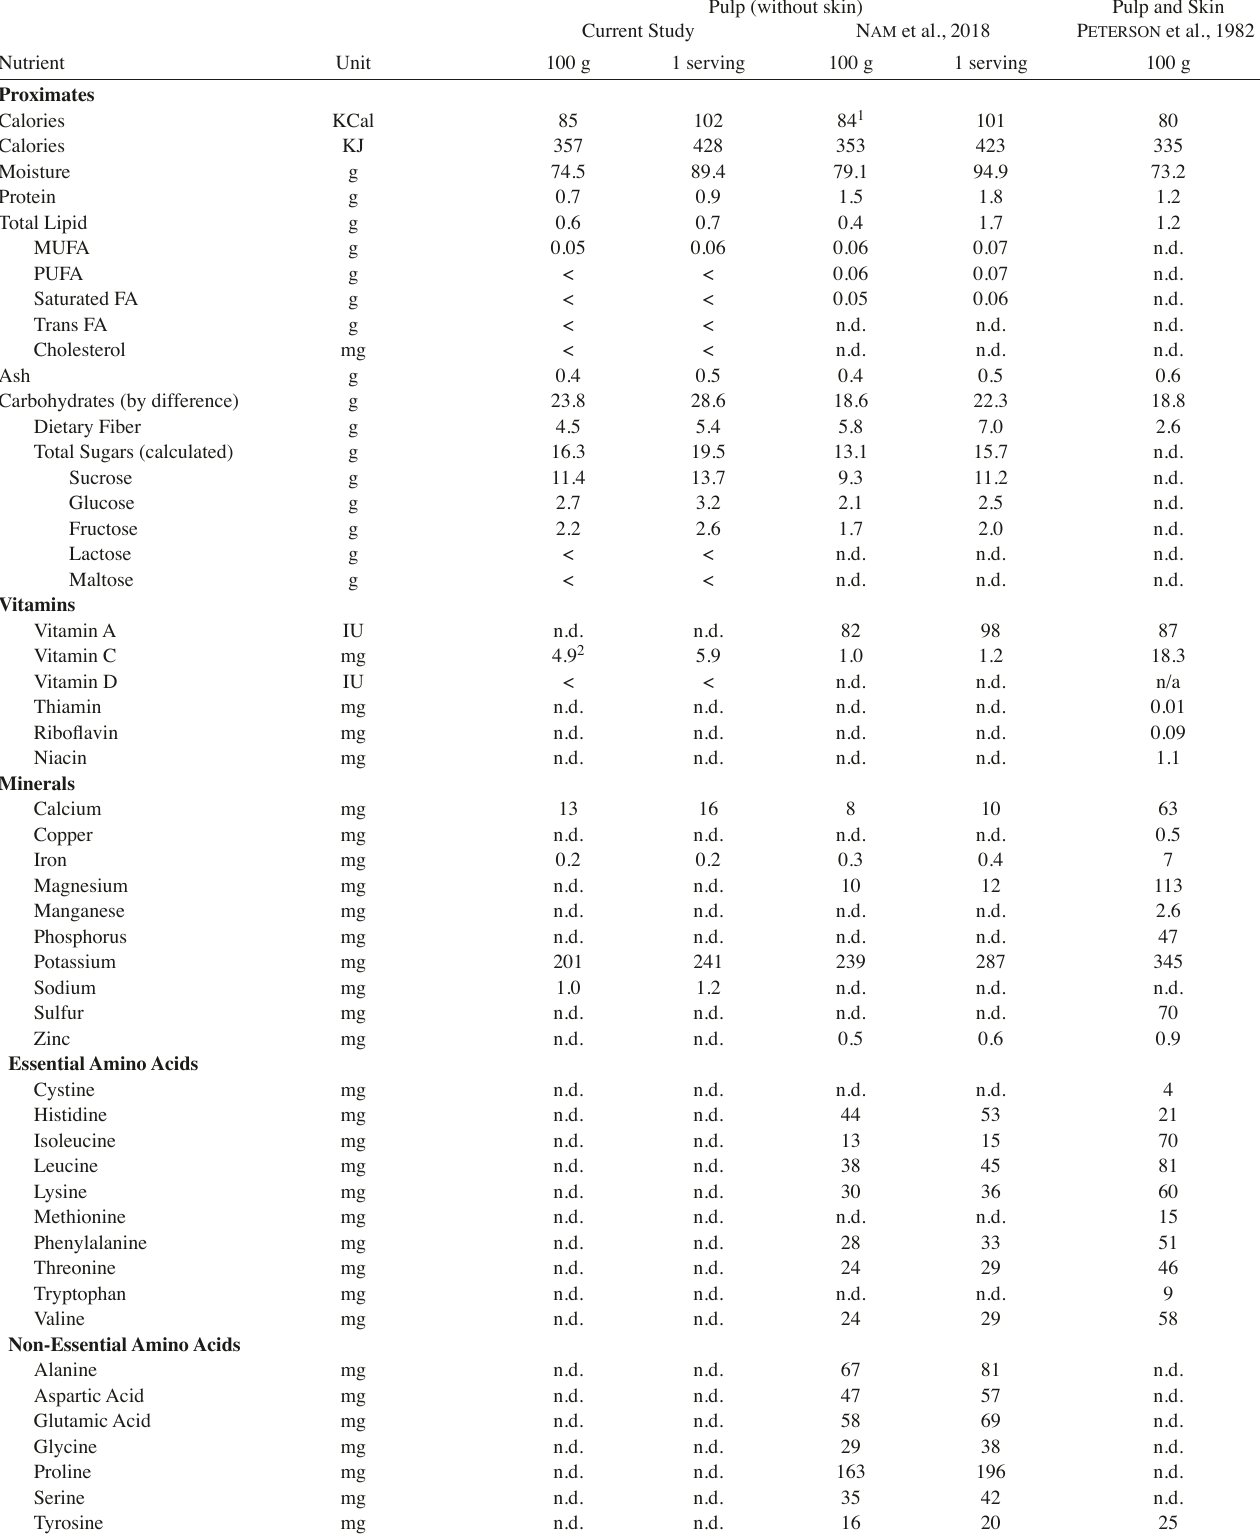
Tab. 5: Pawpaw ( Asimina triloba ) nutritional information for 100 g of pulp, one serving of pulp (1/2 cup, 120 g), and 100 g of pulp with skin. (“n.d.” indicates that the nutrient was not included in the analysis. The “<” symbol indicates the nutrient was analyzed but could not be detected at or above the threshold